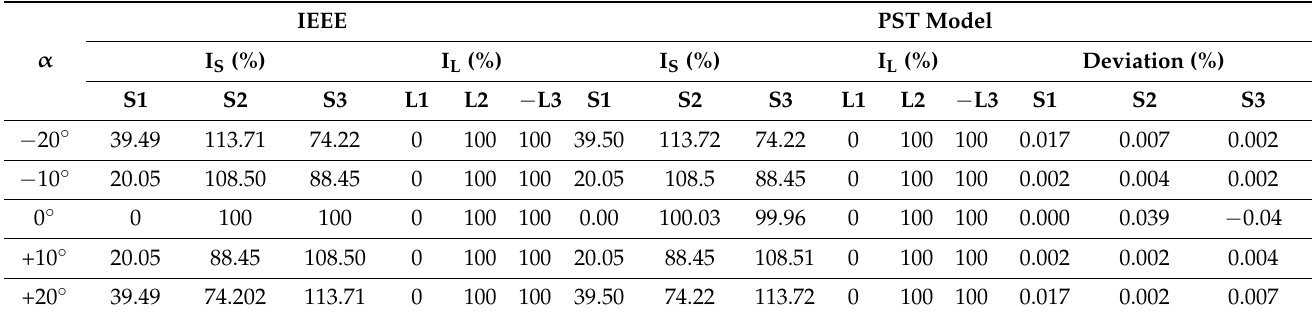
Table 5. Short circuit currents contribution for phase-to-phase fault scenario (L2–L3).